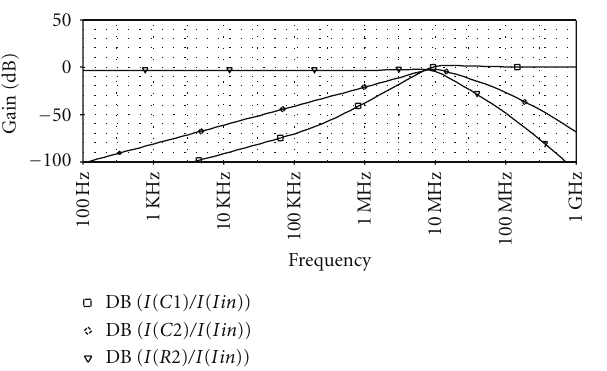
Figure 5: Gain plot in dB showing all three responses.